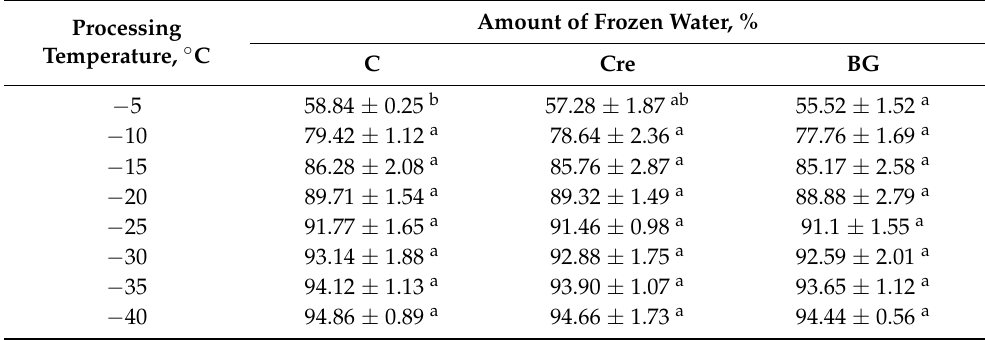
Table 4. The content of frozen water in ice cream under different temperature treatment regimes. Amount of Frozen Water, % Processing Temperature, ◦ C C Cre BG − 5 58.84 ± 0.25